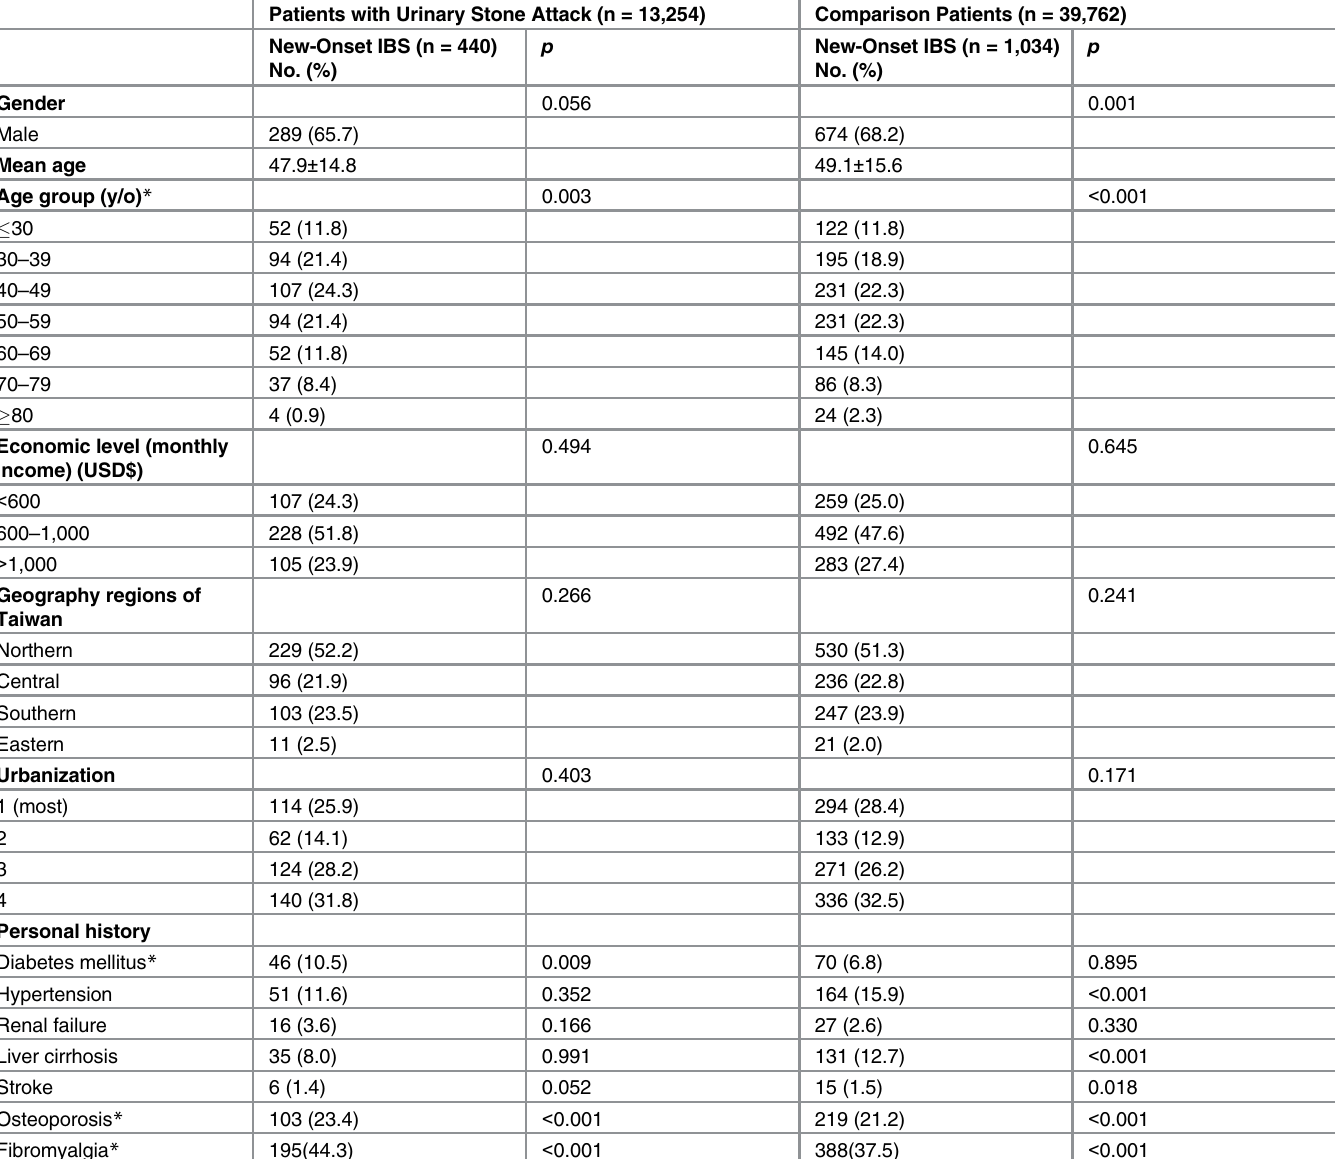
Table 4. Clinical features associated with new-onset irritable bowel syndrome in patients with urinary stone attack. Patients with Urinary Stone Attack (n = 13,254) Comparison Patients (n =